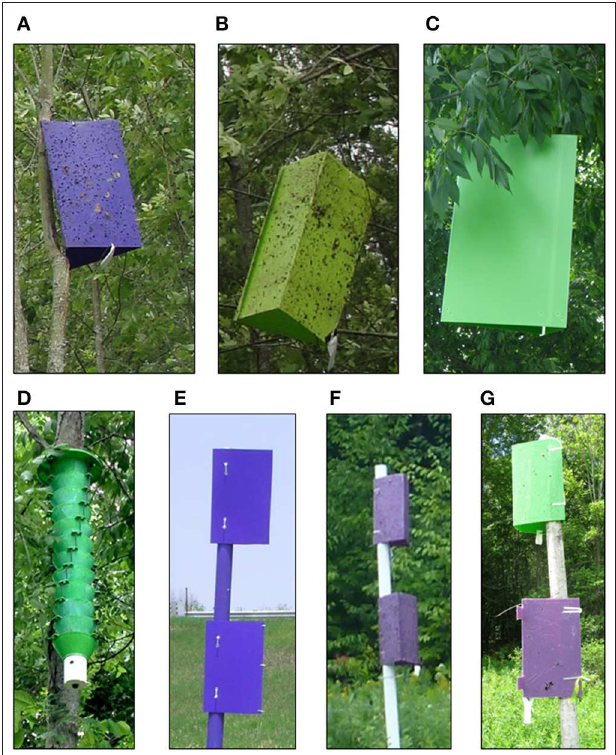
FIGURE 1 | Trap types used in Agrilus planipennis trapping experiments. (A) Dark purple sticky prism trap. (B) Light green sticky prism trap. (C) Dark green sticky prism trap. (D) Dark green funnel trap. (E) Double-decker trap with dark purple upper and lower prisms. (F) Double-decker trap with light purple upper and lower prisms. (G) Double-decker trap with dark green upper prism and light purple lower